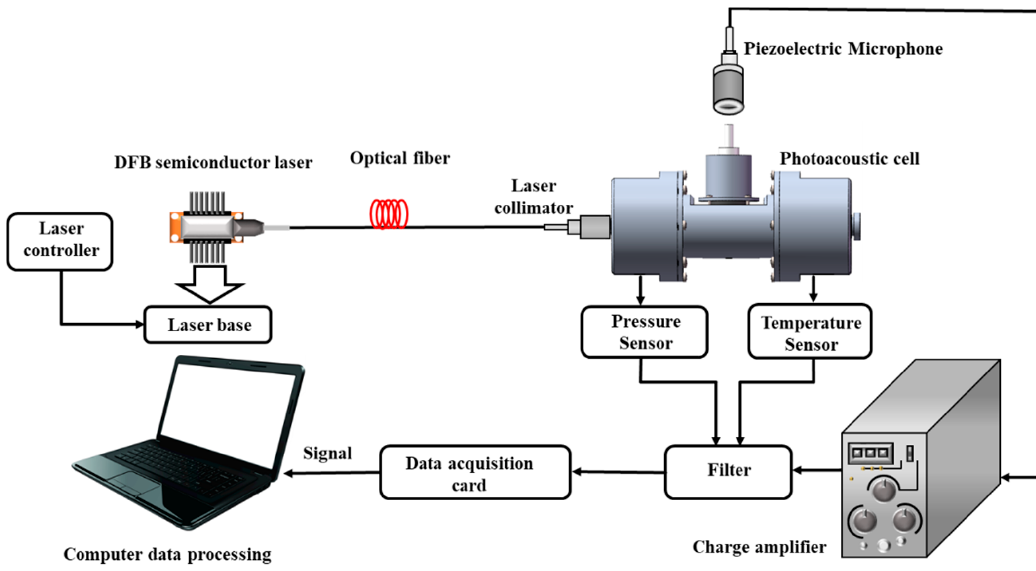
Figure 1. Structure diagram of the device.